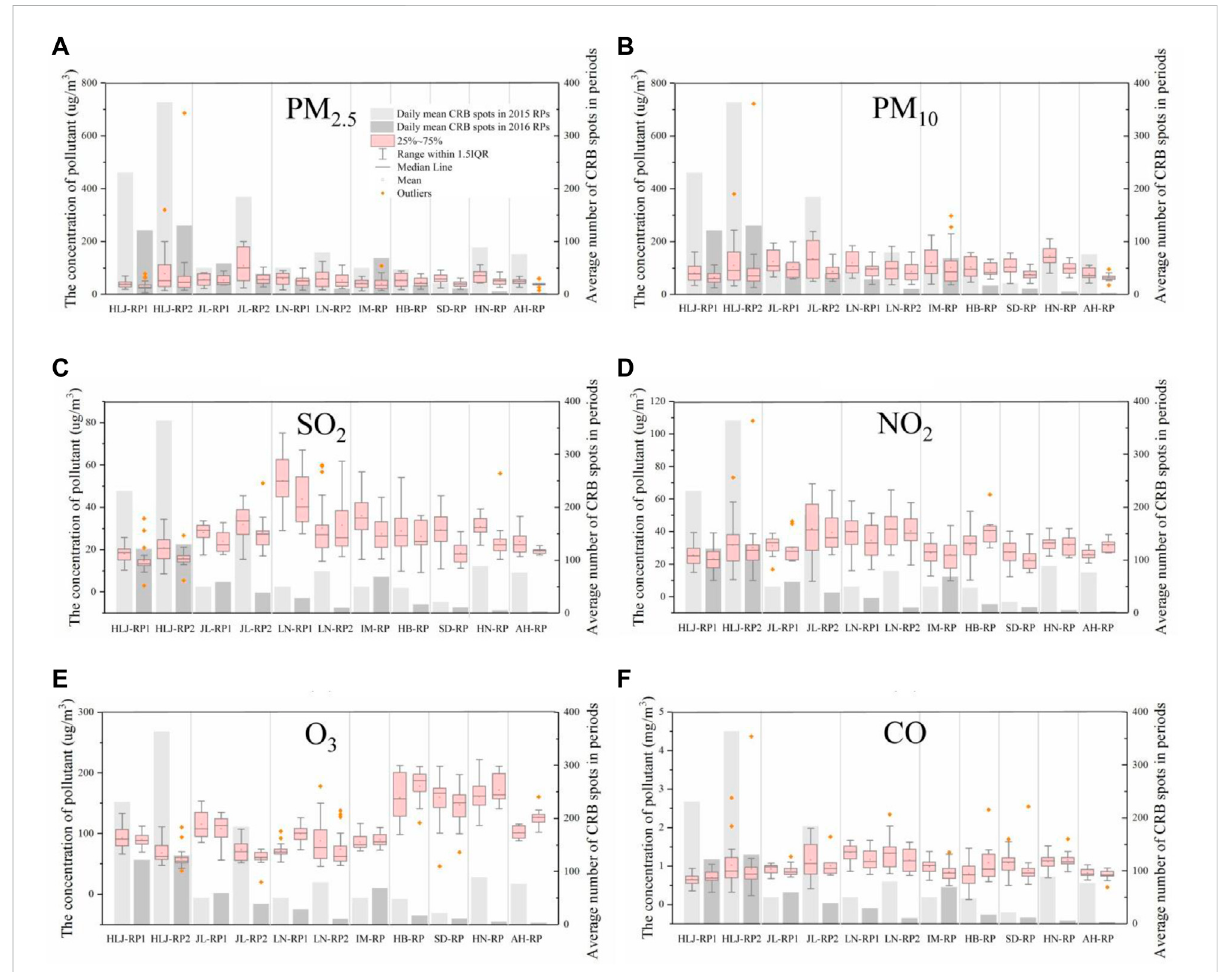
FIGURE 4 Boxplots of six air pollutants in Pds at the provincial level in 2015 and 2016 for (A) PM 2 . 5 , (B) PM 10 , (C) SO 2 , (D) NO 2 , (E) O 3 , and (F)